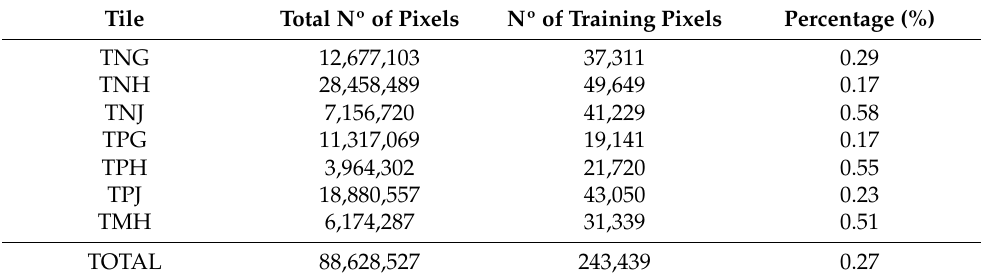
Table 3. For each Sentinel-2 tile: Number of 20 × 20 m 2 pixels within Galician territory, number of 20 × 20 m 2 pixels used as training pixels, and percentage of the total Galician surface area covered by training